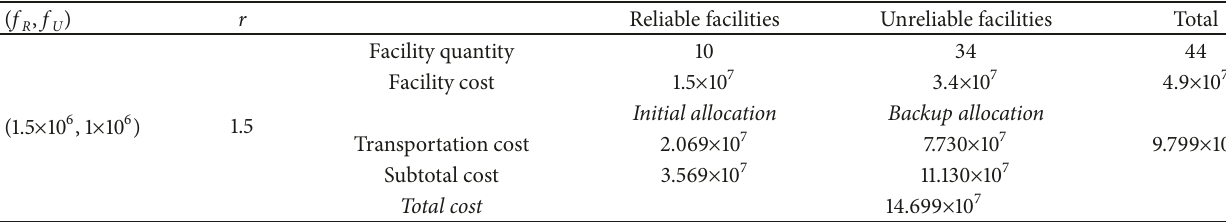
Table 1: Optimal numerical solution.